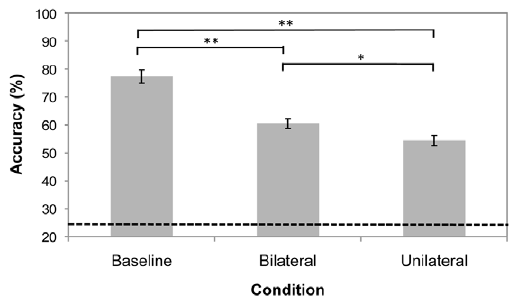
Figure 2. Mean tracking accuracy for the three conditions in Experiment 1. The broken line shows chance performance, which is 25% as two yes/no questions were asked per trial and both had to be answered correctly for the trial to be counted as correct. Error bars denote within-observers standard error [38]. *Significantly different at p , 0.01; **Significantly different at p ,